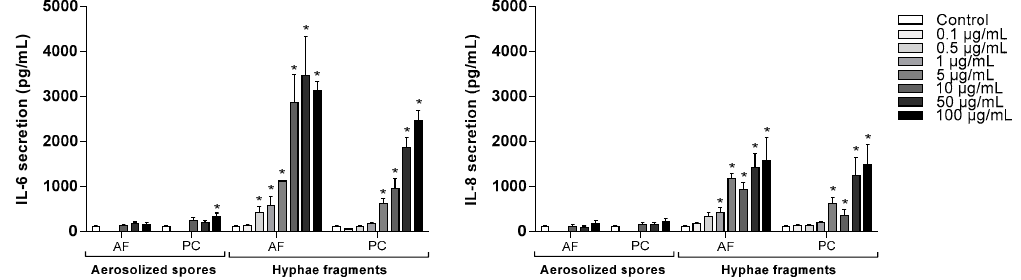
Figure 3. Release of IL-6 and IL-8 from BEAS-2B after exposure to spores and hyphal fragments from A. fumigatus and P. chrysogenum . Cells were exposed to different concentrations of X-ray treated aerosolized spores, hyphal fragments or medium (controls) for 6 h. Release of IL-6 and IL-8 were measured by ELISA. Bars represent mean ± SEM of 3–7 independent experiments. Statistical analyses were performed by two-way ANOVA with Dunnett’s post-tests on log transformed data. Significant difference compared to the control denoted by * p < 0.05.